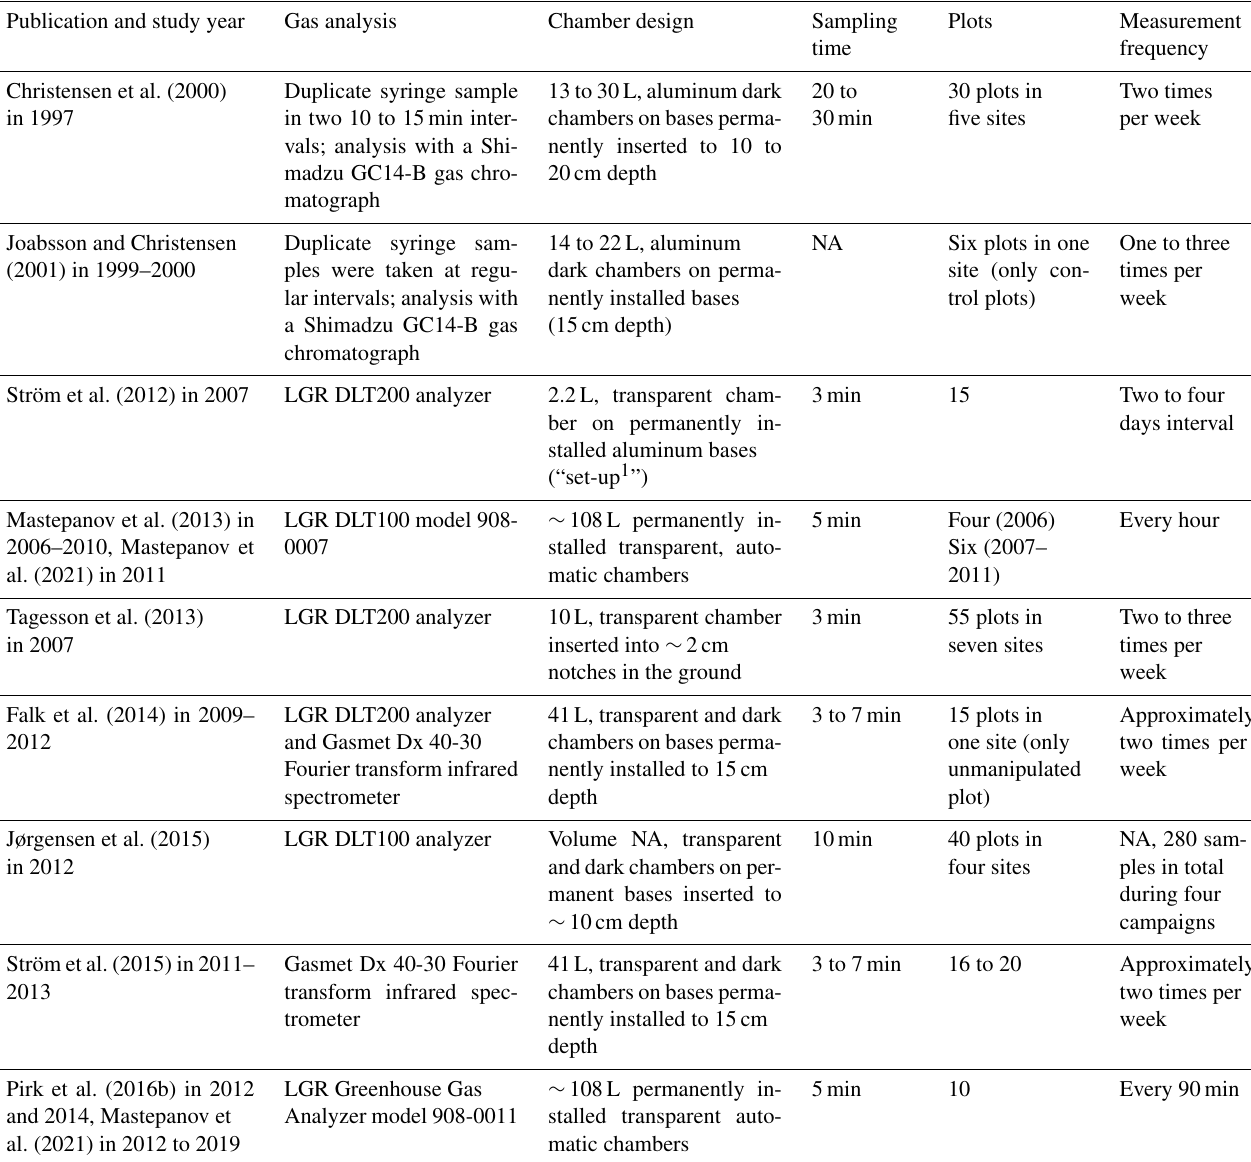
Table 2. Flux chamber measurements in Zackenberg Valley vary in several ways between studies. Please see each study for a detailed description of the methods. Only the data used in this study are included in the table, i.e., unmanipulated and control